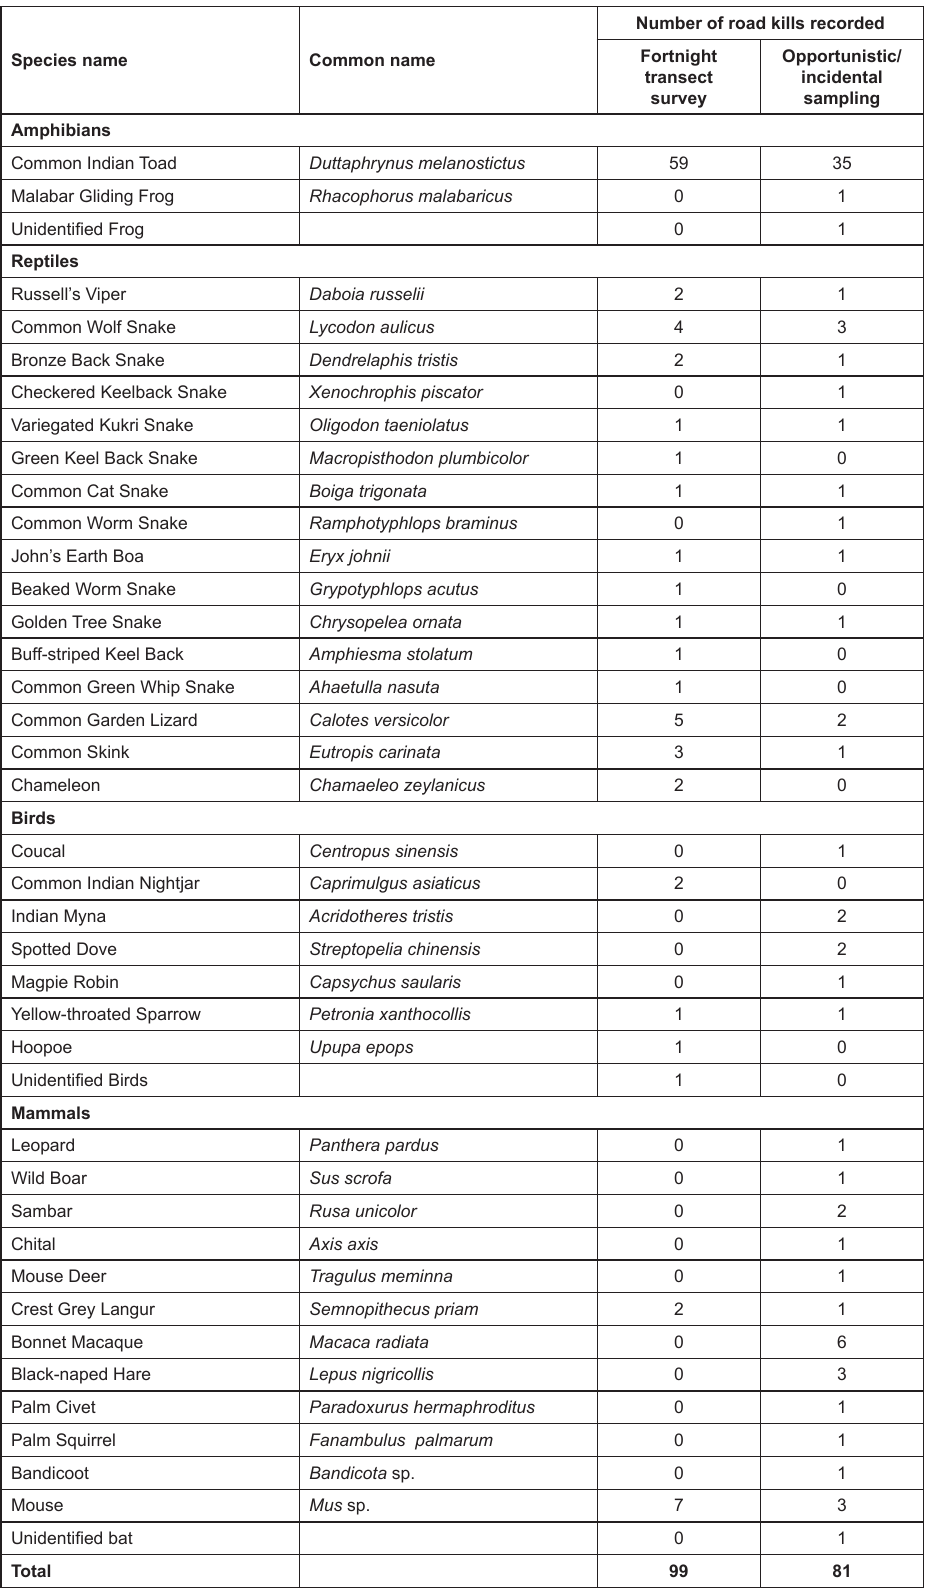
Table 2. List of road kills recorded at Mudumalai Tiger Reserve, southern India (a total 248km covered in transect survey at the rate of 62 km/month) between December 1998 and March